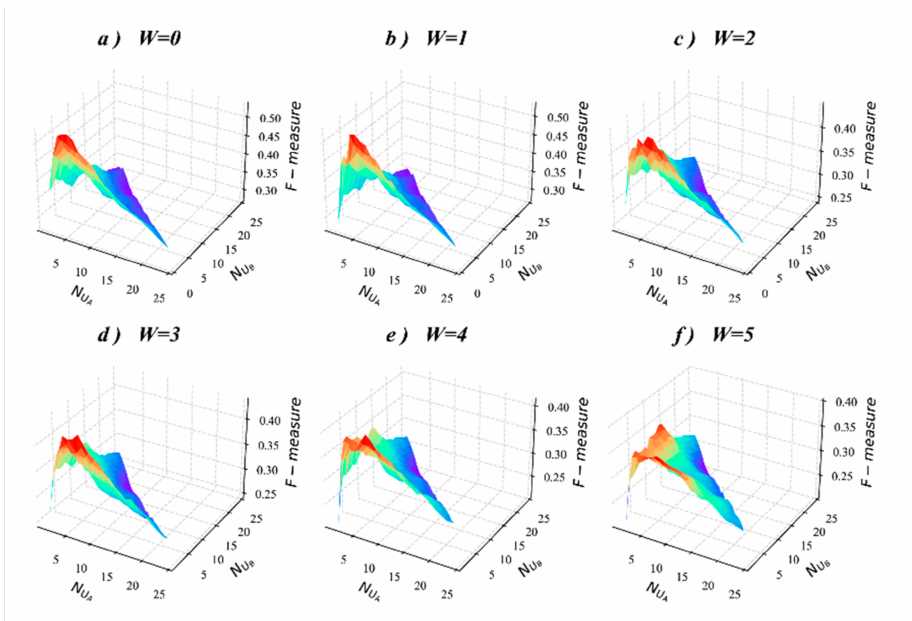
Figure 7. The F-measures of different values of w .